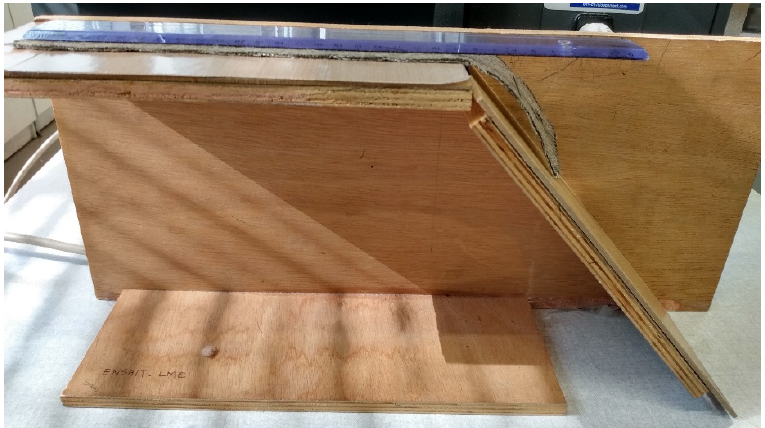
Figure 3. Cantilever test